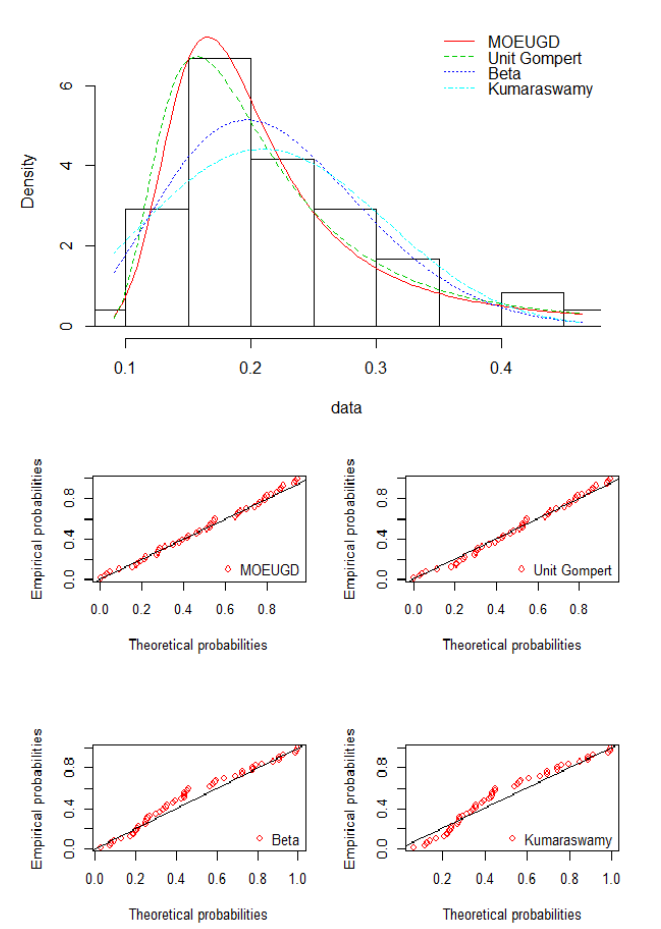
Figure 4 – Density fit and P-P plots of the distributions for the Rock Sample